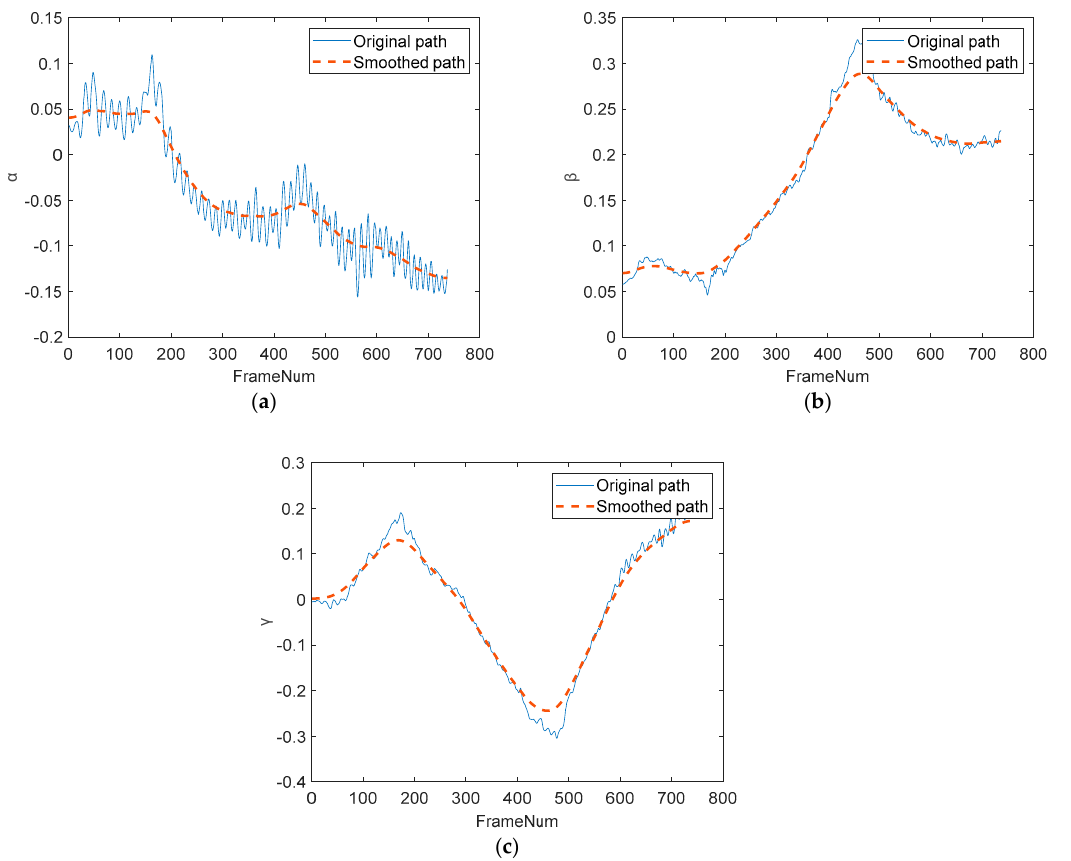
Figure 2. Gyroscope path smoothing: ( a ) α path smoothing; ( b ) β path smoothing; ( c ) γ path smoothing.